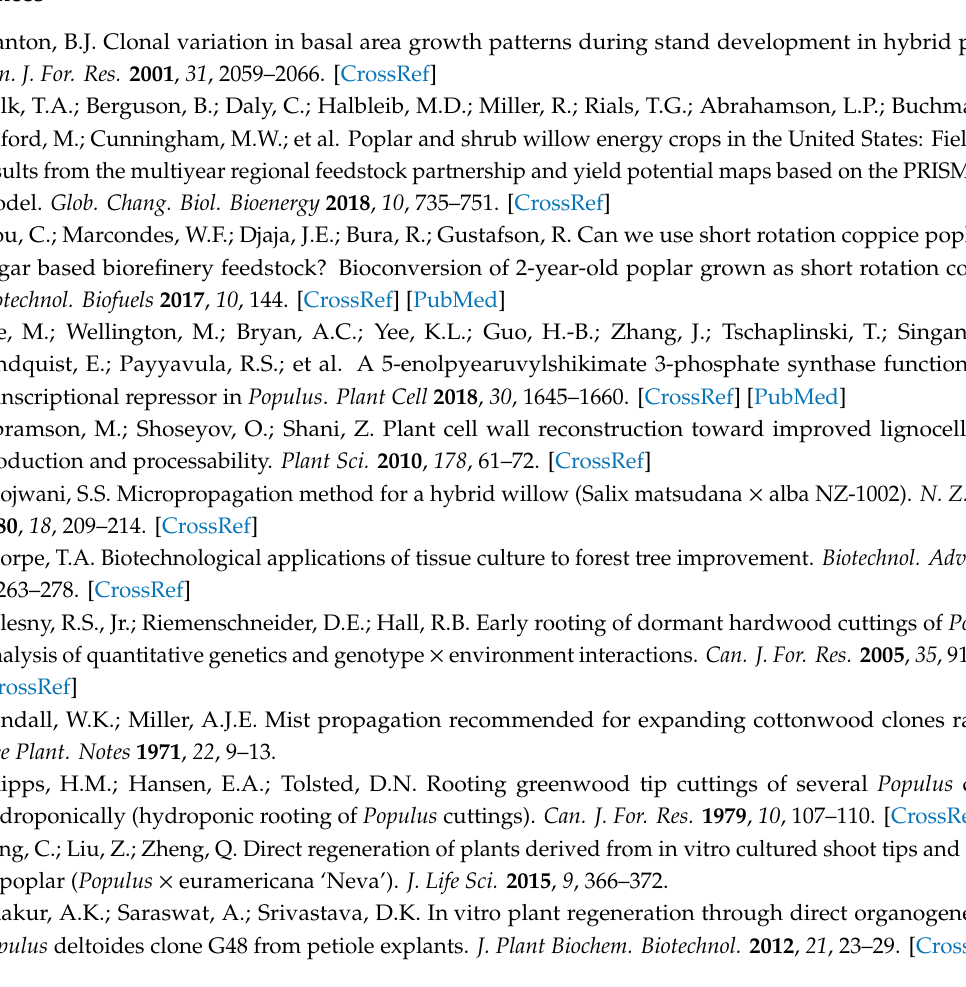
Table S1: Analysis of variance in